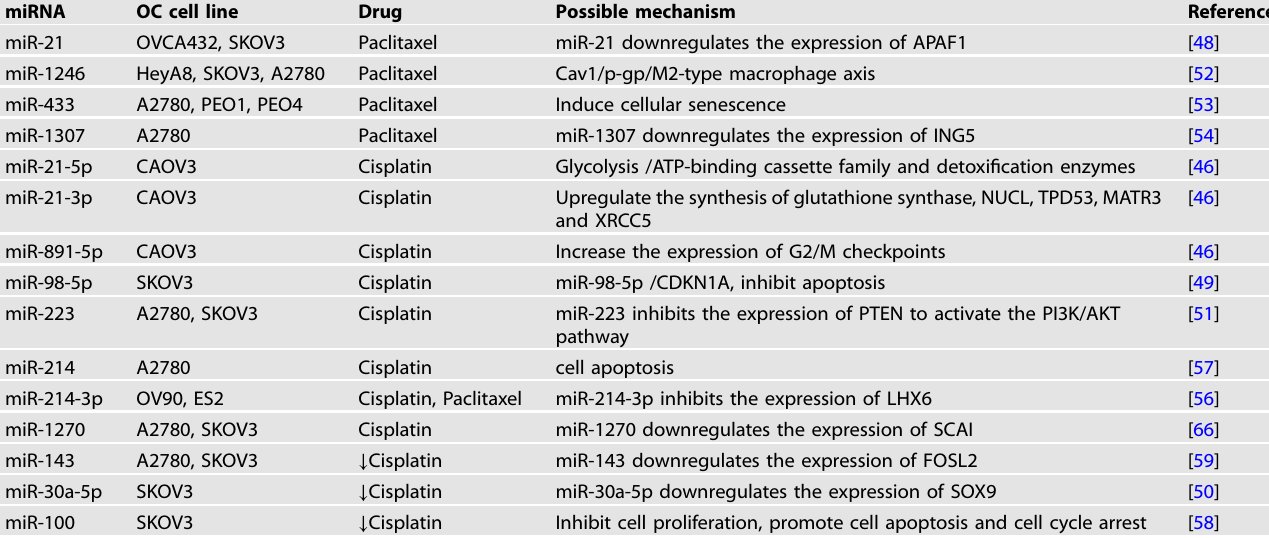
Table 1. Summary of EV miRNAs in OC